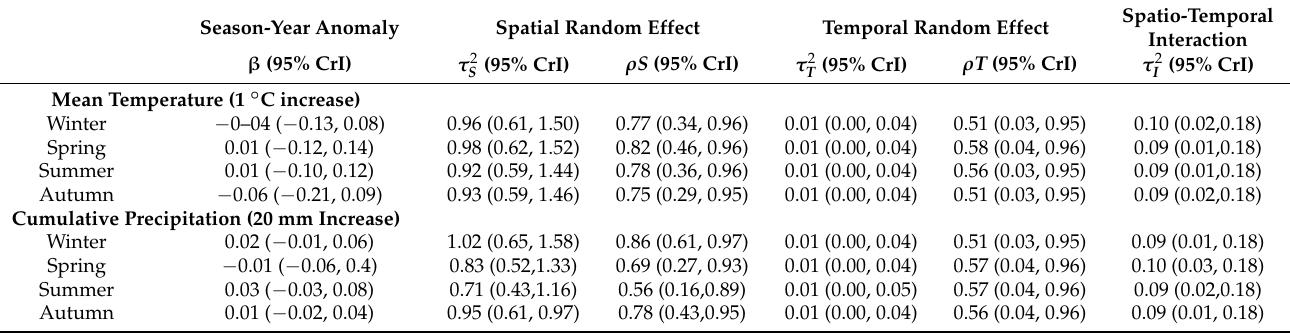
Spatio-Temporal